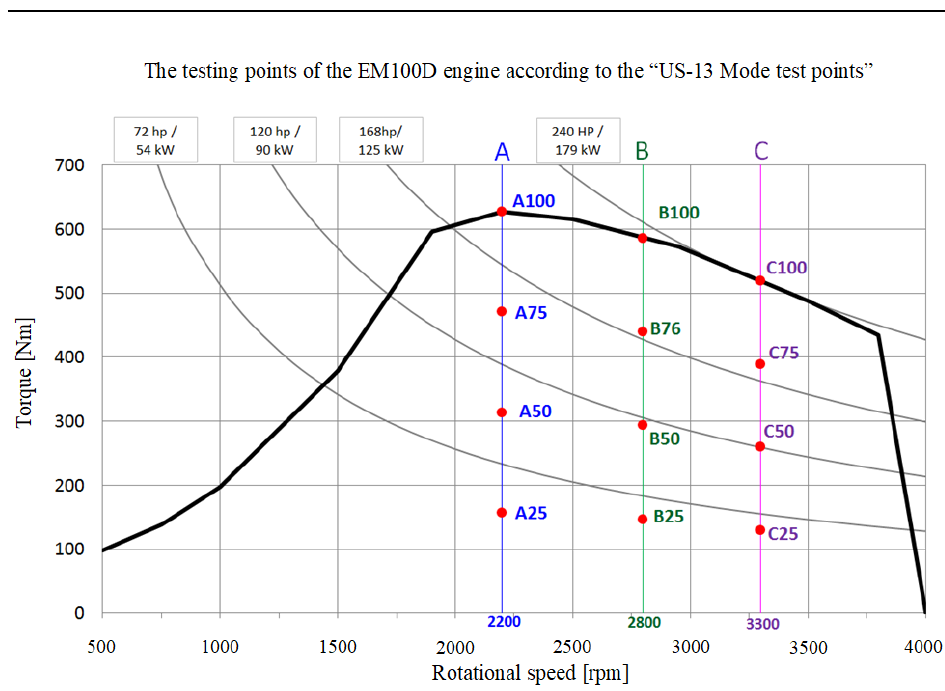
Figure 9. The variation of the air utilization coefficient in the simulation conditions for the combustion chamber 1 (ovoid shape).